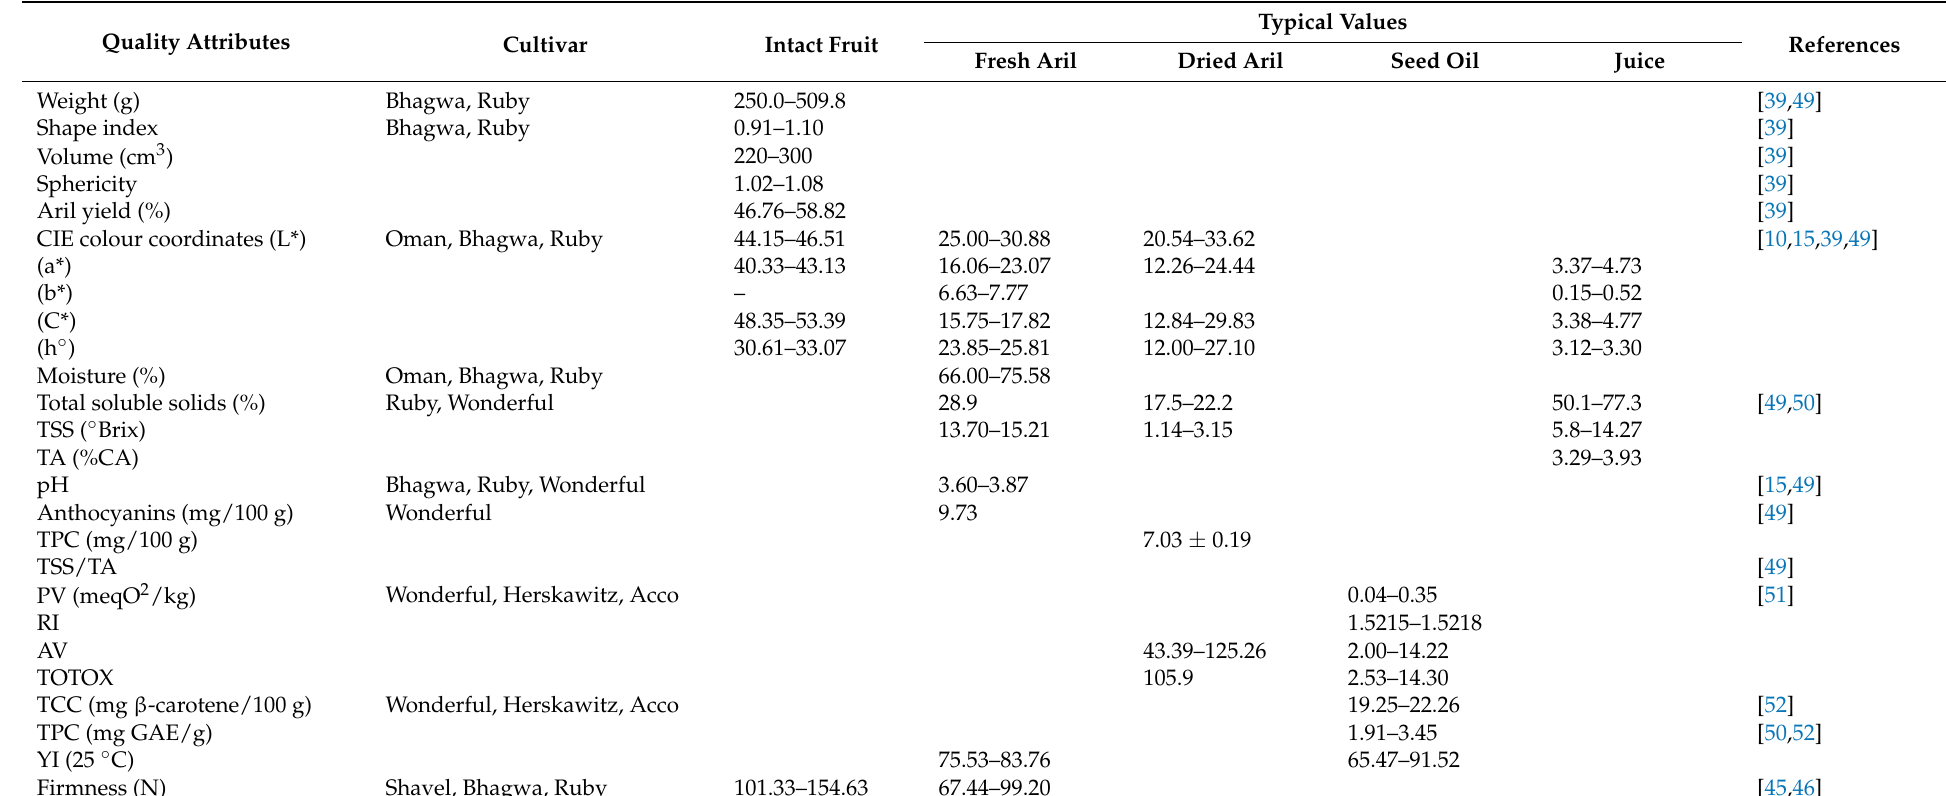
Table 1. Summary of typical quality indicator values for intact pomegranate fruit and